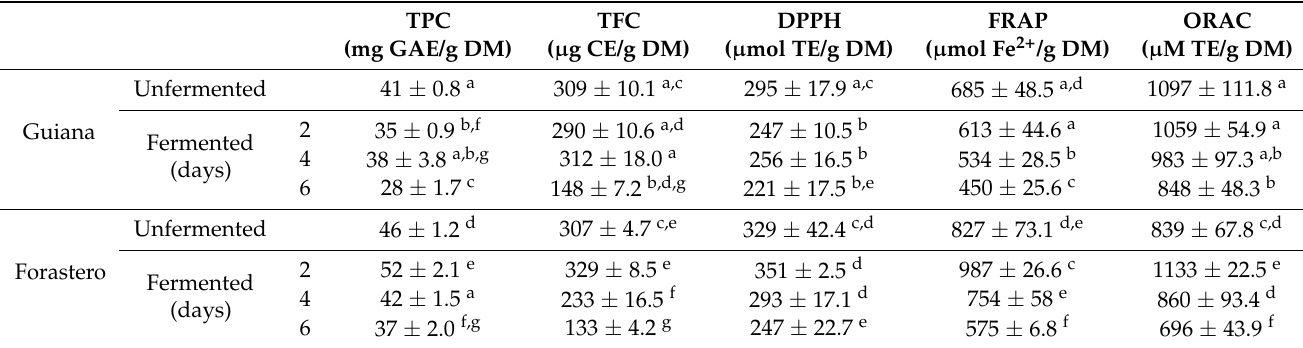
Table 1. Guiana and Forastero antioxidant activities, total polyphenolic and total flavonoid